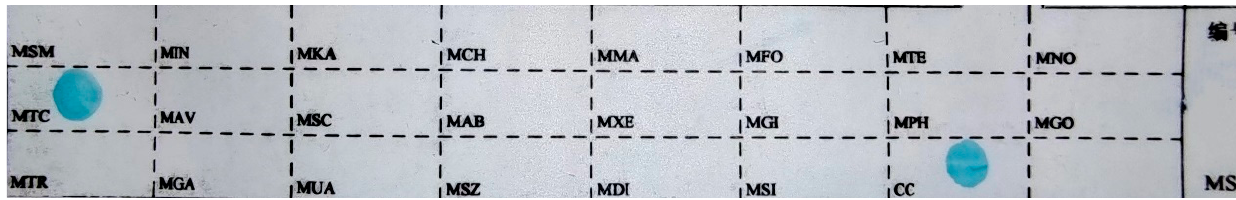
Figure 1. Sequence of detection site on membrane strip. MTC, Mycobacterium tuberculosis complex; CC, quality control site; the rest were non-tuberculous mycobacterium detection sites. The Chinese in the upper right corner means that you can write numbers in this area to number the membrane strips.